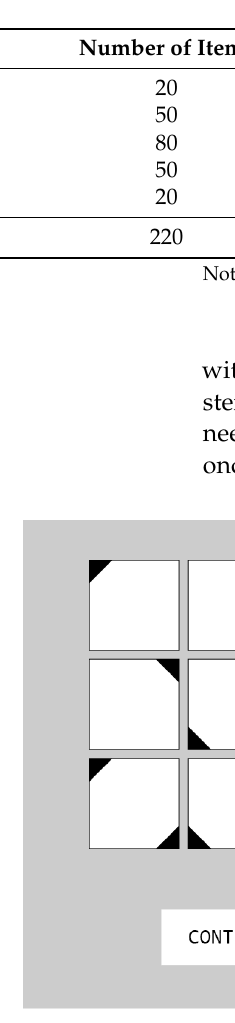
Figure 1. Example item from the current study. On the left, the item stem is presented with eight cells being filled and the last one left empty. Participants are required to use the construction elements on the right to construct the correct response. In this item, the corner elements are added within the rows; thus, the correct response would be to select all four corner elements. Clicking on the button would switch to the next item until all items were solved.